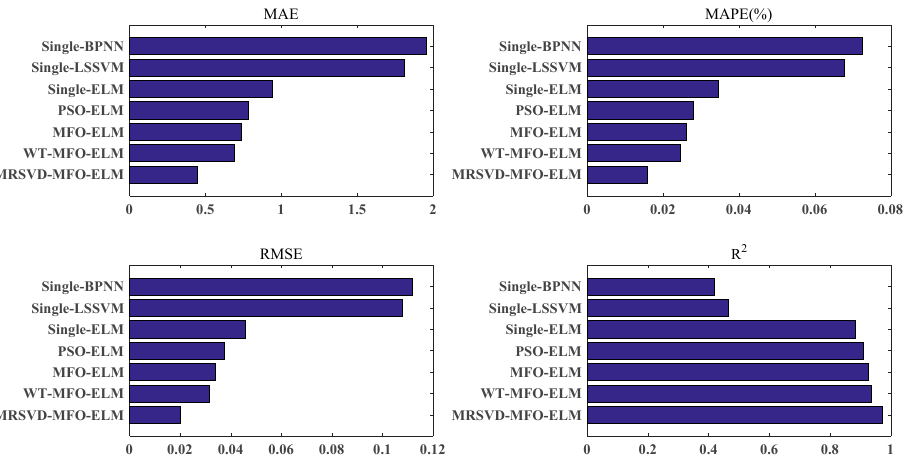
Figure 17. Evaluation criteria values of seven models for Hubei carbon price forecasting.